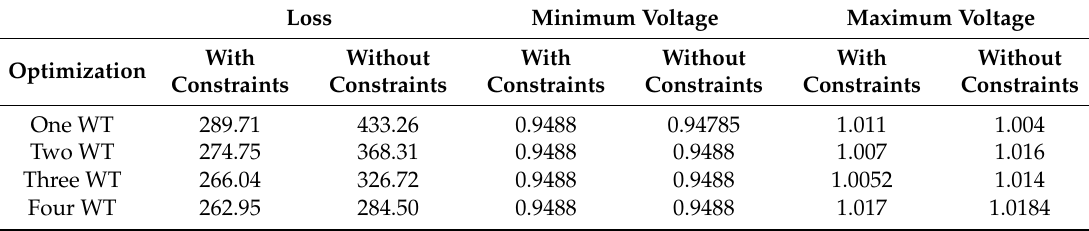
Table 5. Comparison of results with and without regard to the 84-bus